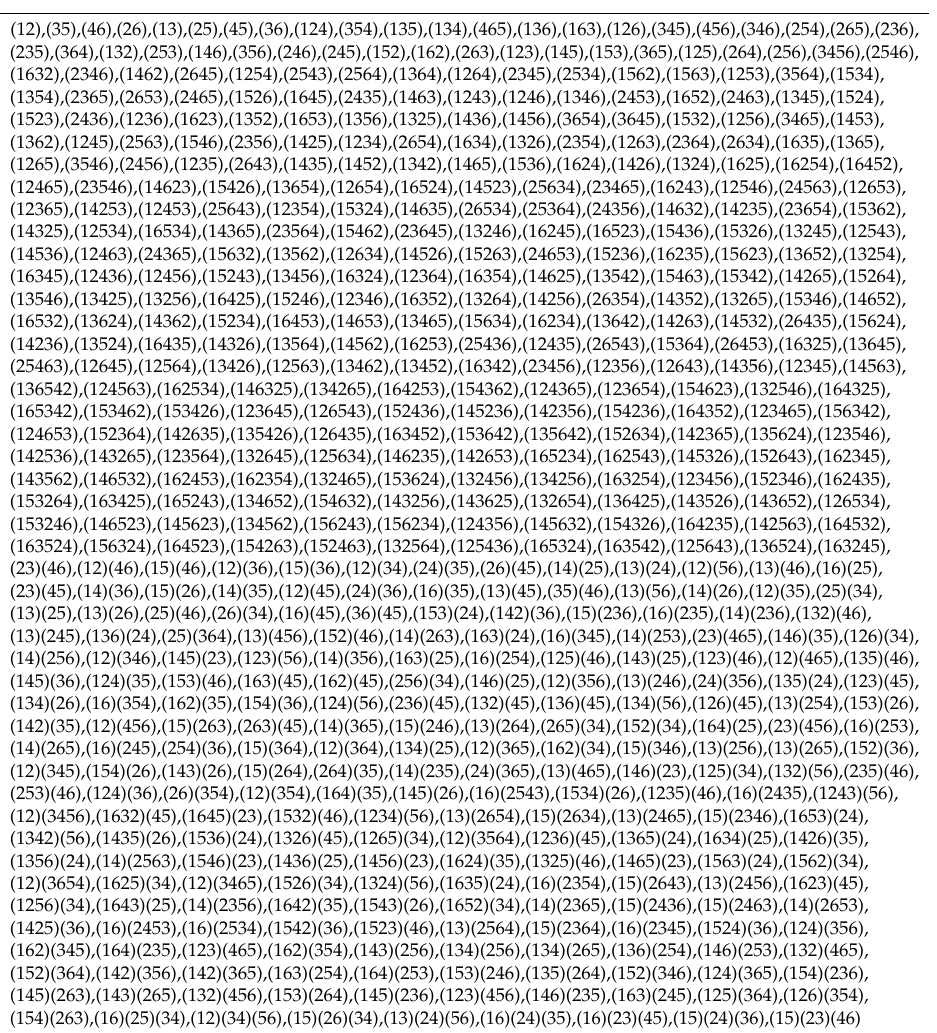
Table 2. 576 permutations which are not in p ( C )